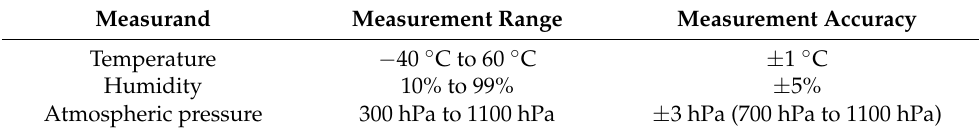
Figure 3. The SBS-WS-400 weather station mounted at the roof of the Institute of Telecommunications, selected as the reference one. Table 3. Chosen parameters of the SBS-WS-400 weather station, selected as the reference